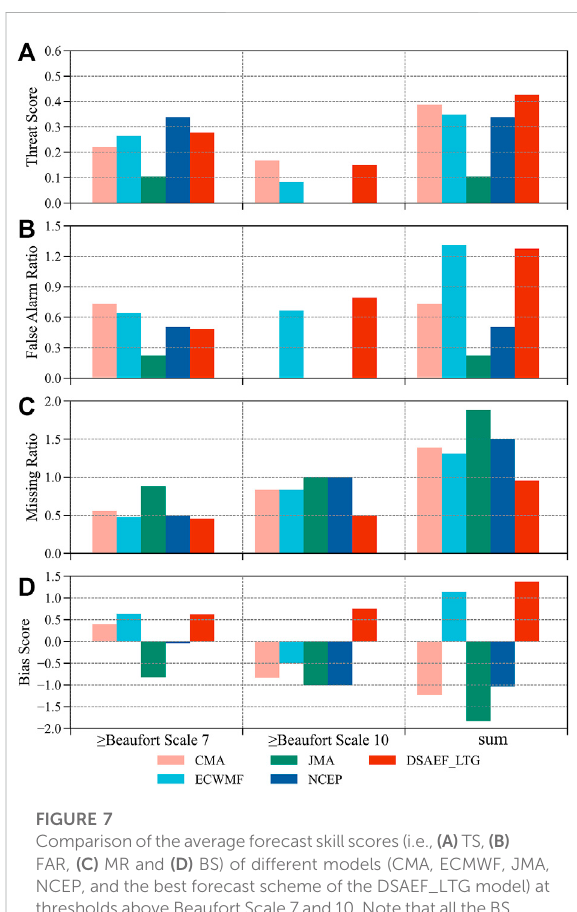
scatter point in Figure 6 represents a forecast scheme, and the red scatter point denotes the best forecast scheme determined by TSsum (i.e., TS6 = 0.4063 and TS8 = 0.4389). Furthermore,